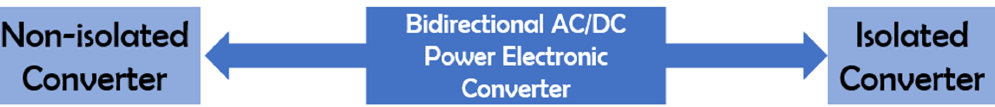
Figure 9. Classification of bidirectional AC / DC power converter topologies: the bidirectional AC / DC power electronic converters are mainly of two types, isolated and non-isolated converters.